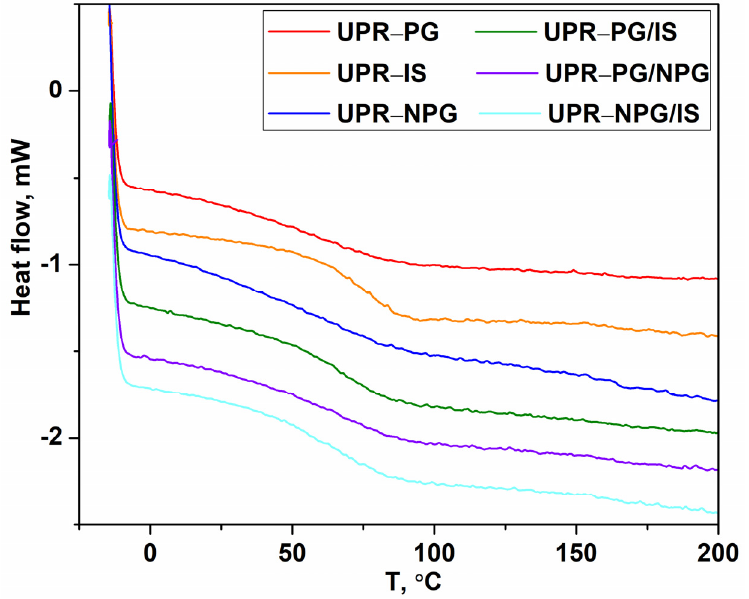
Figure 4. DSC thermograms of cured samples. Table 2. The UPRs gel content and glass transition temperature obtained by DSC (Tg DSC ) and DMA